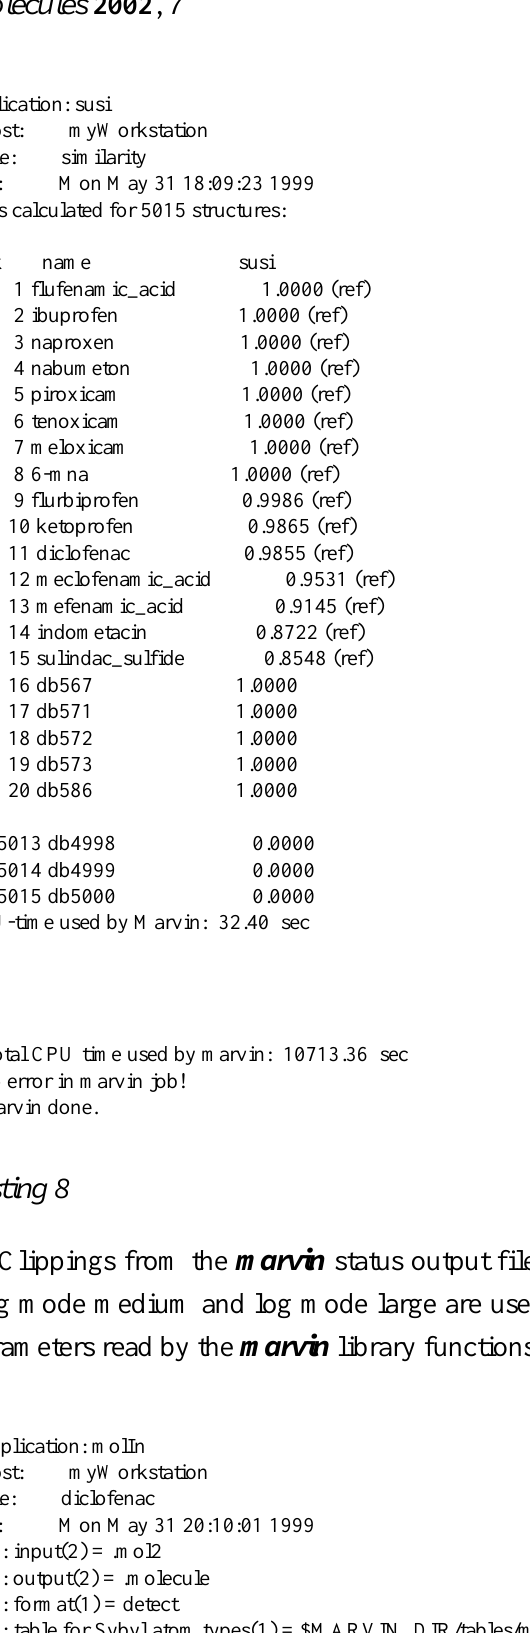
read: table for Sybyl atom types(1) = $MARVIN_DIR/tables/molIn/AtomTypesSybyl.table read: table for Sybyl bond types(1) = $MARVIN_DIRmarvin/tables/molIn/BondTypesSybyl.table Reading molecule from Sybyl-.mol2 file: diclofenac.mol2 writing maff-file